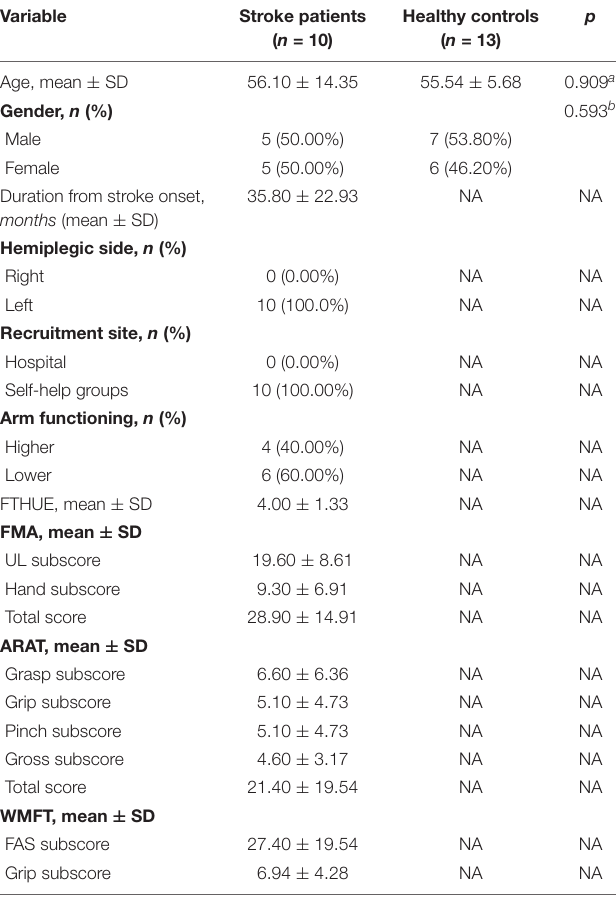
TABLE 1 | Baseline characteristics of the study population.